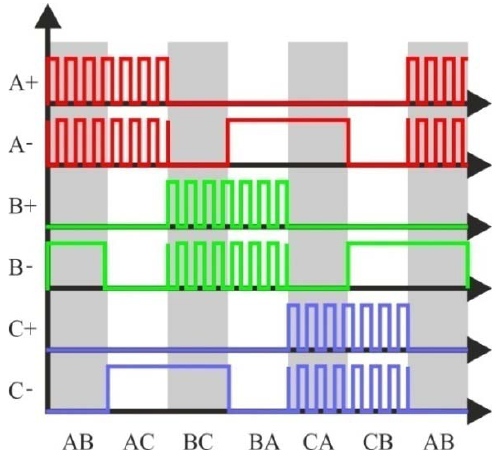
Figure 15. Complementary PWM algorithm